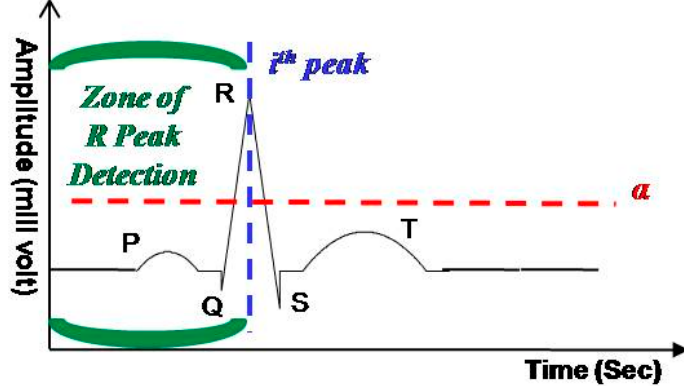
Figure 2. The principle of QRS selection.